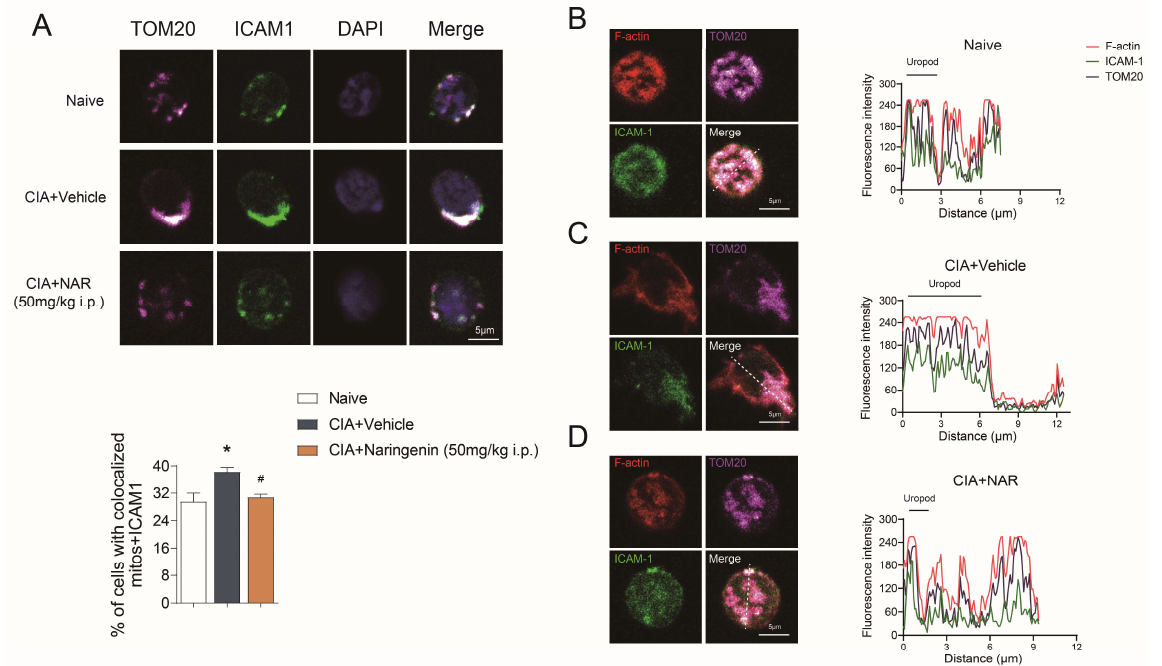
Figure 4. NAR affected the mitochondrial distribution in spleen CD4 + T cells. ( A ) Mitochondria (TOM20) and the uropod marker ICAM1 in different groups. The percentage of cells with colocalized mitochondria and ICAM1 is shown in the graph (n = 3 rats per group). Naive group ( B ), CIA + Vehicle group ( C ), CIA+Naringenin (50 mg/kg i.p.) ( D ) CD4 + T lymphocytes were stained for the indicated proteins (F-actin (detected using fluorescent phalloidin); ICAM-1; and TOM20) and (left) imaged by confocal microscopy; the uropod is marked with ICAM-1. (Right) Fluorescence intensity analysis was performed from the uropod to the leading edge (L.E.) over the line represented at the merge image. * p < 0.05 vs. naive group, # p < 0.05 vs. CIA model group, by repeated-measures one-way ANOVA followed by post hoc Dunnett’s multiple comparisons test. All scale bars are 5 µm. The data are presented as means ± SEM (3 sections and 5 different fields of each section were randomly selected for colocalized analysis).